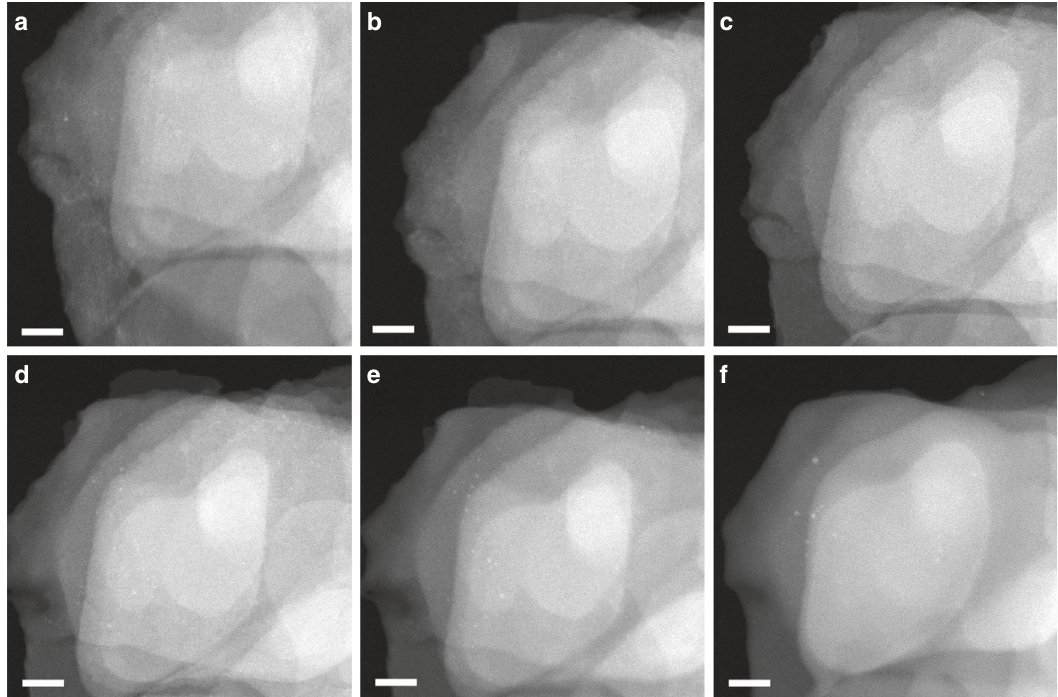
Fig. 5 Stability test of 0.17%Pt@MCM-22-300H 2 under CO + NO conditions. During the in situ TEM experiments, the sample was treated in mixture of CO (0.1 torr) and NO (0.1 torr) for 15 min at different reaction temperature, respectively. In order to avoid the carbon deposition of CO by the electron beam, the TEM chamber was evacuated to remove CO gas after exposure of the sample to CO+NO gases. a 200 °C, b 400 °C, c 600 °C, d 800 °C, e 1,000 °C, f 1,200 °C. Scale bar in all the images in this fi gure: 20